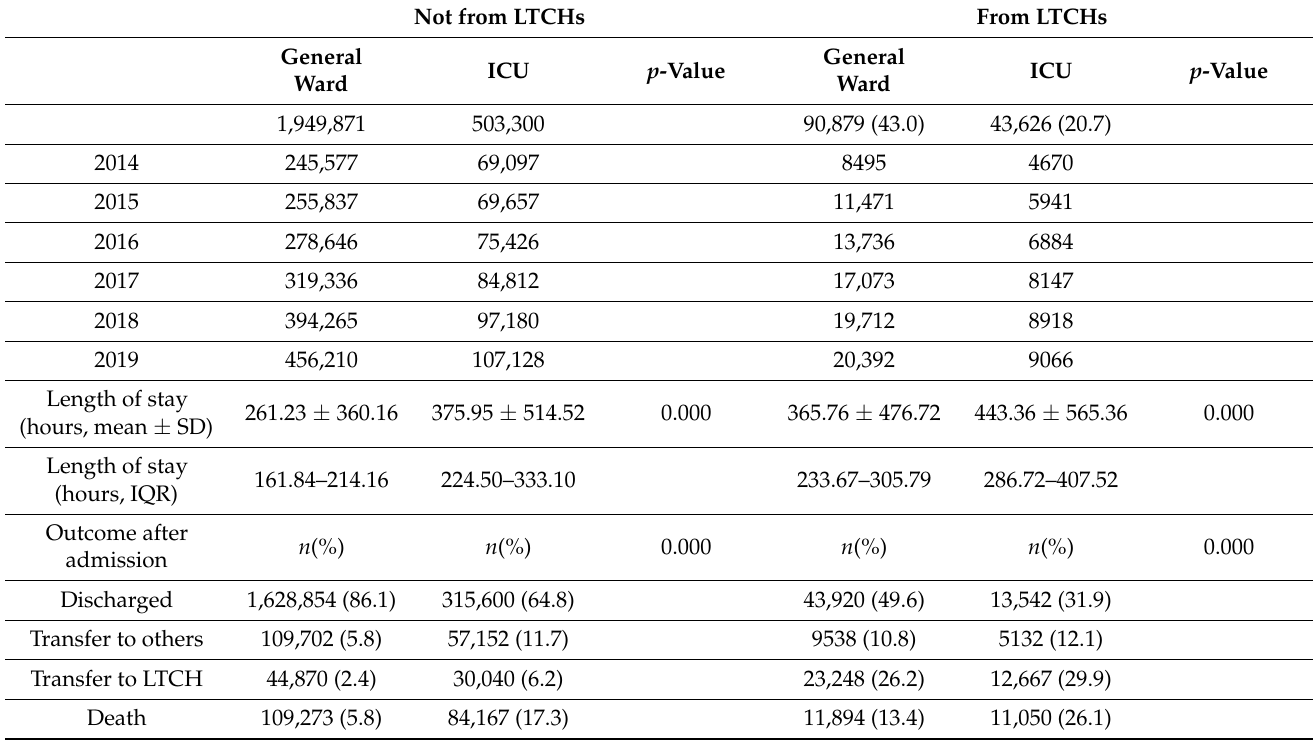
Table 3. Length of hospital stay and